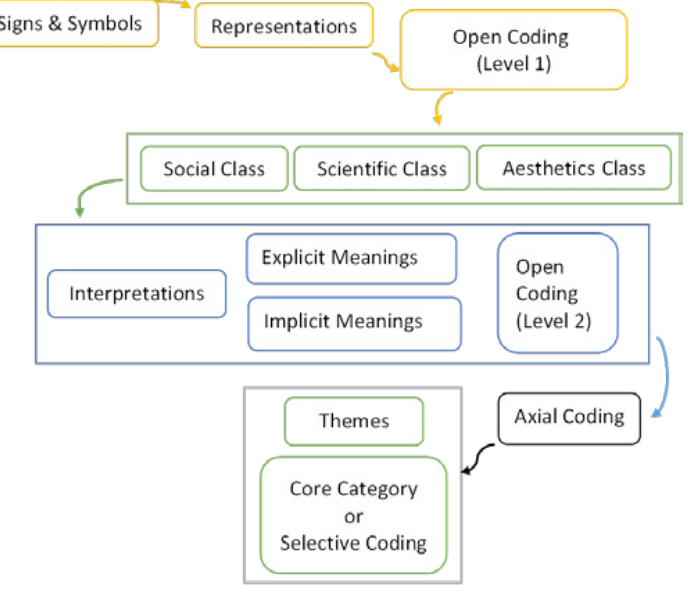
Fig.2: Framework of the Study Fig. 2: Framework of the